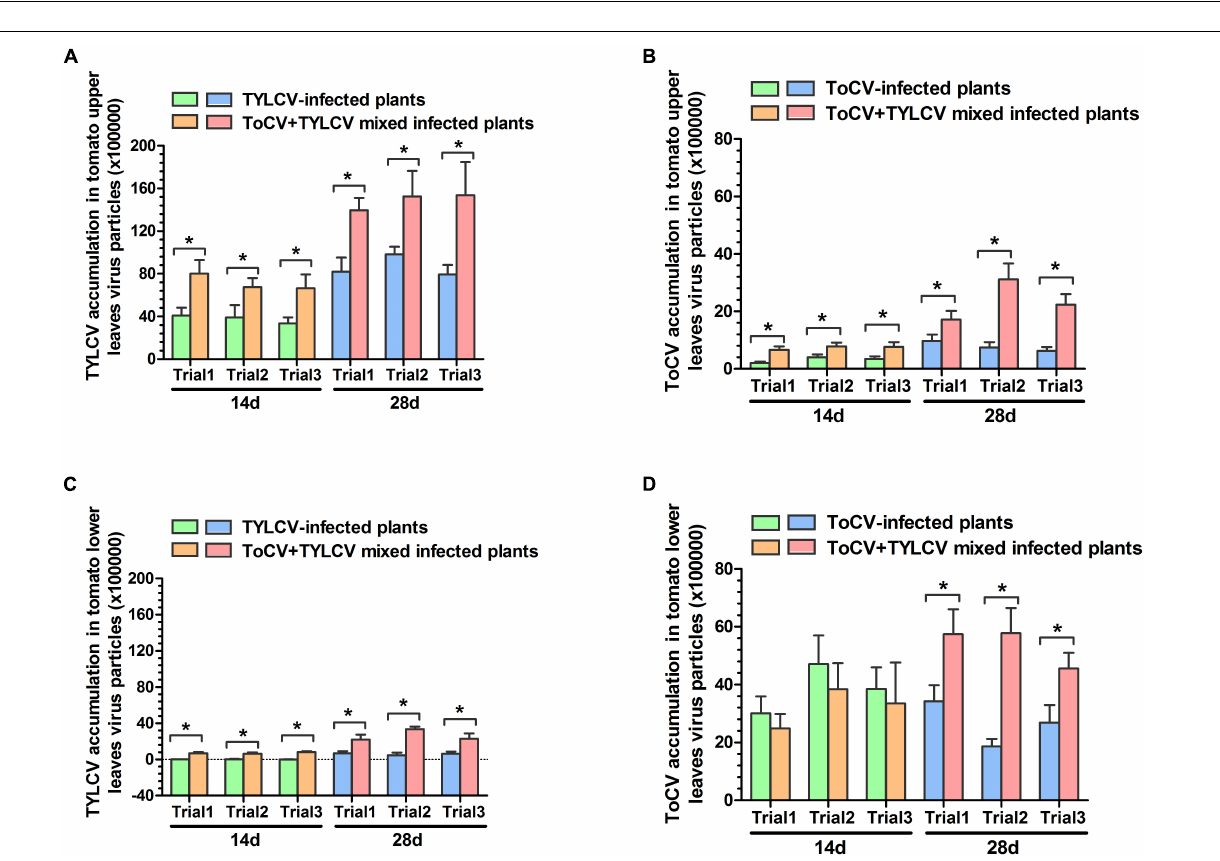
FIGURE 4 | Tomato chlorosis virus (ToCV) and Tomato yellow leaf curl virus (TYLCV) accumulations in different virus-infected tomato plants. (A) ToCV accumulation in upper leaves of ToCV-infected and ToCV+TYLCV mixed infected plants. (B) ToCV accumulation in lower leaves of ToCV-infected and ToCV+TYLCV mixed infected plants. (C) TYLCV accumulation in upper leaves of TYLCV-infected and ToCV+TYLCV mixed infected plants. (D) TYLCV accumulation in lower leaves of TYLCV-infected and ToCV+TYLCV mixed infected plants. Asterisks indicate a significant difference between single infection and mixed infection (Student’s t -test, P <